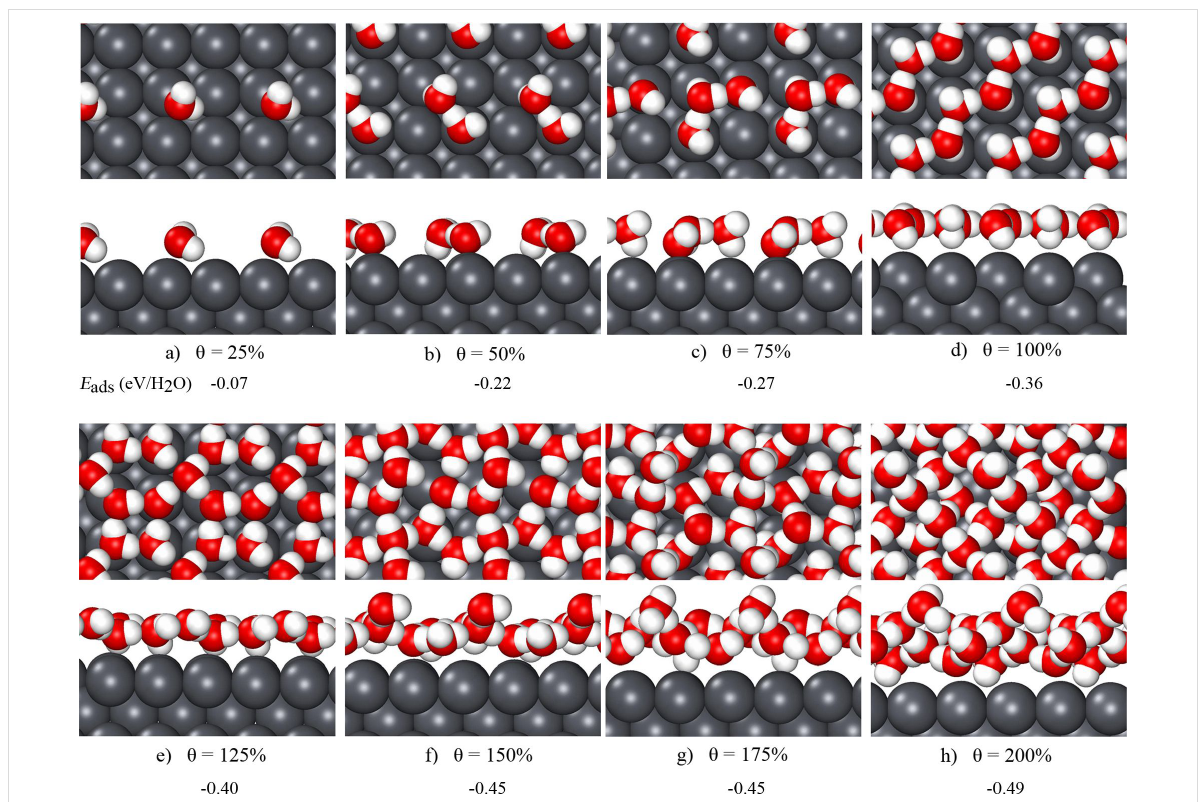
Figure 2: Top and side views of minimum-energy water structures on Pb(100) for coverages from 25 to 200%. The corresponding adsorption ener- gies in electronvolts per water molecule are listed below of the corresponding panels.